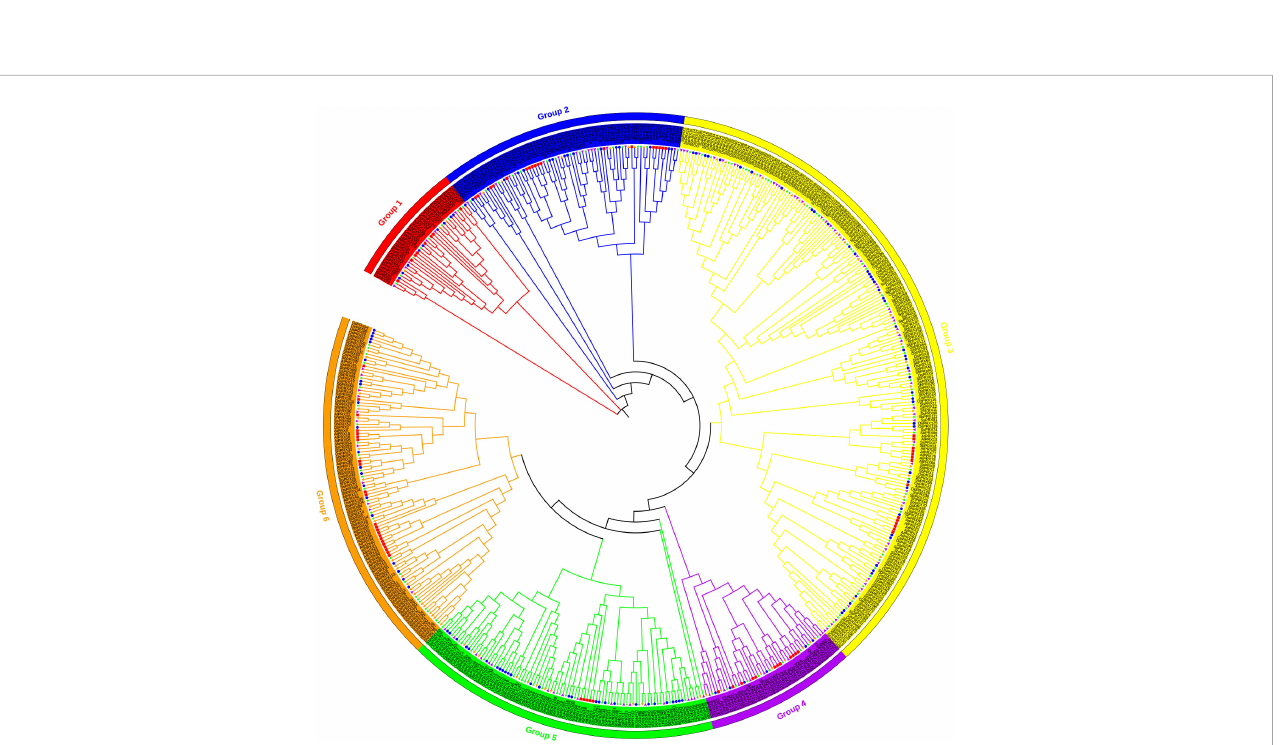
FIGURE 2 Phylogenetic analysis of PRX proteins from A. thaliana, O. sativa, S. bicolor, S. spontaneum , and sugarcane. AtPRX , red rectangle in the fi gure; OsPRX , blue circle in the fi gure; SbPRX , green star in the fi gure; SsPRX , purple right-pointing triangle in the fi gure; ShPRX , orange left-pointing triangle in the fi gure.